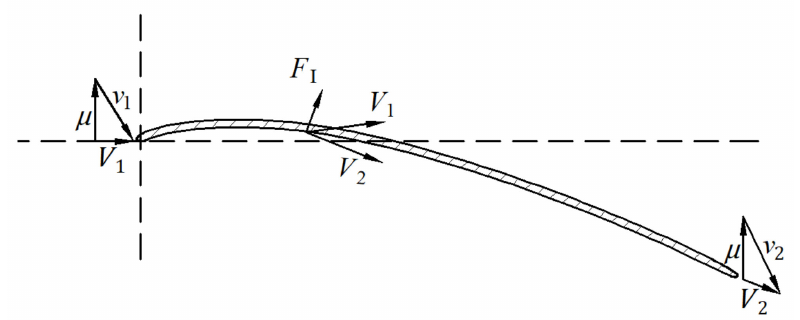
Figure 8. Impact-resistance model.